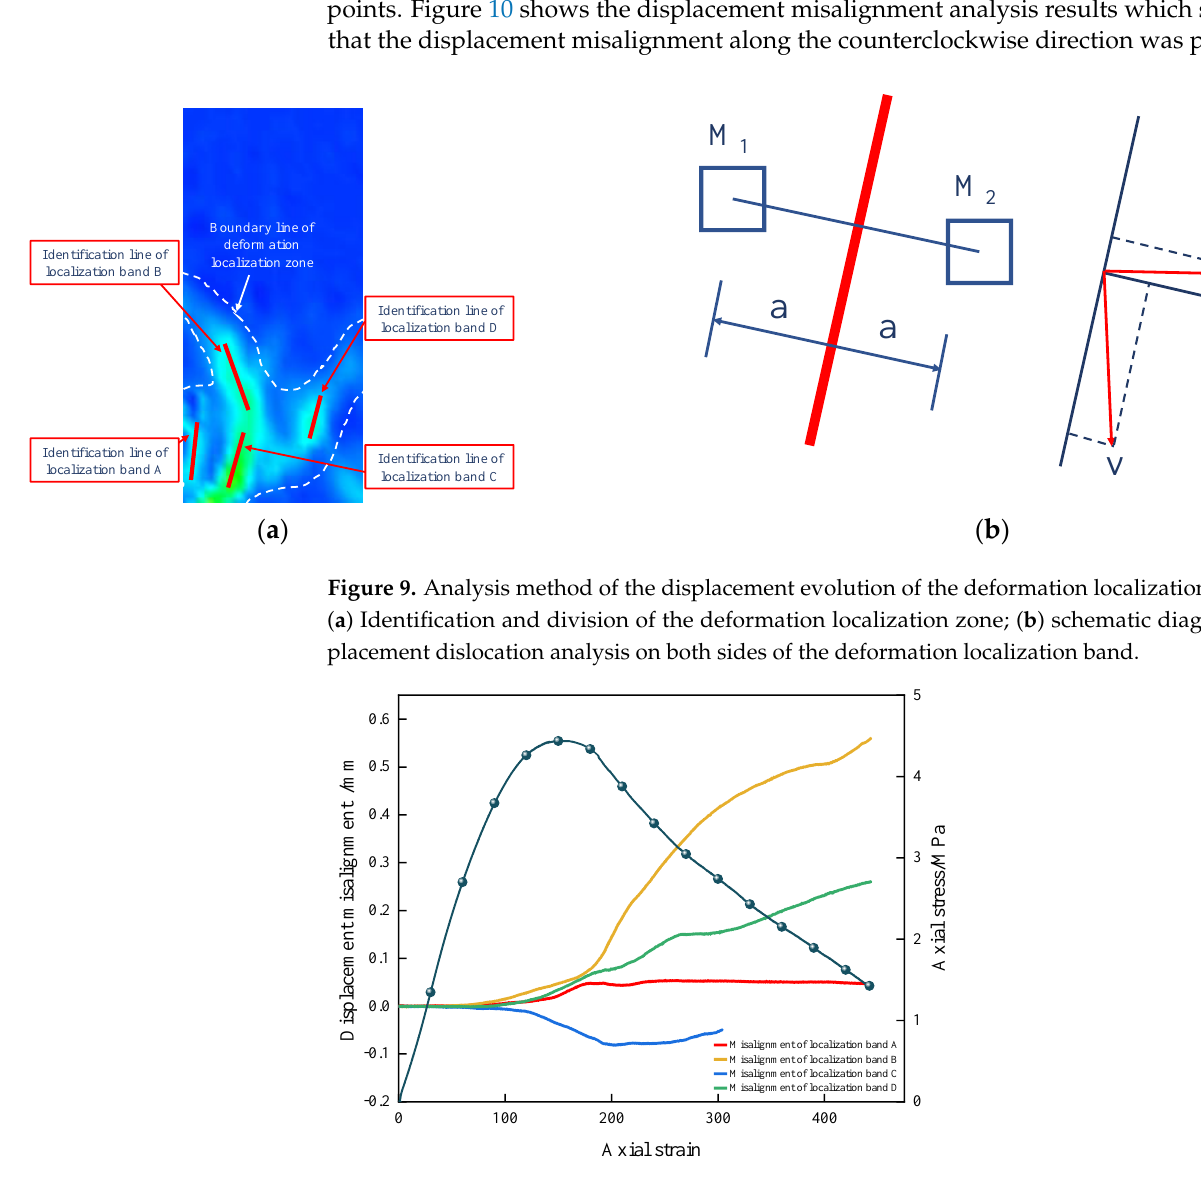
Figure 10. Evolution curves of the displacement misalignment of the deformation localization band.